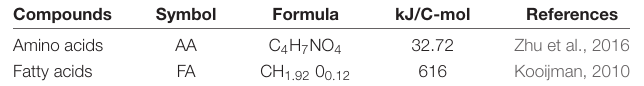
TABLE 3 | Energy content of